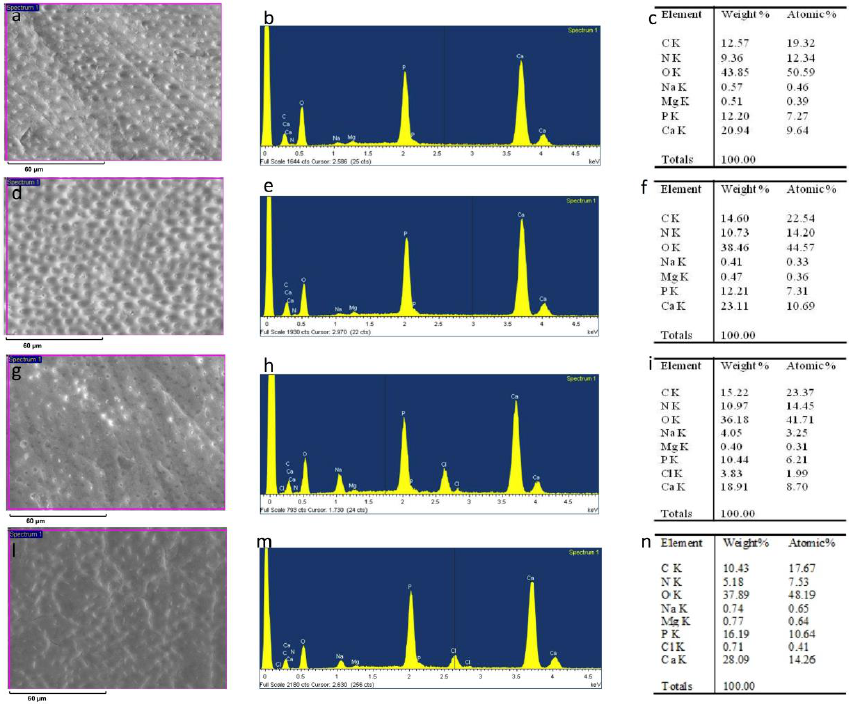
Figure 3. ESEM image, EDX spectra, and table of elements recorded on the dentin surface after sanding with abrasive paper ( a , b , c ), after treatment with a 17% EDTA (Germ EDTA 17%) ( d , e , f ), and after immersion in SBF for 24 h ( g , h , i ) and two months ( l , m , n ). Materials 2018 , 11 , x FOR PEER REVIEW